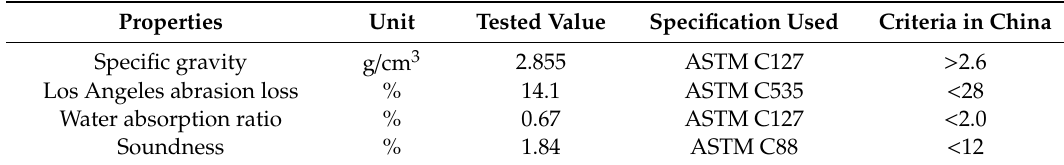
Table 1. Basic physical properties of basalt.